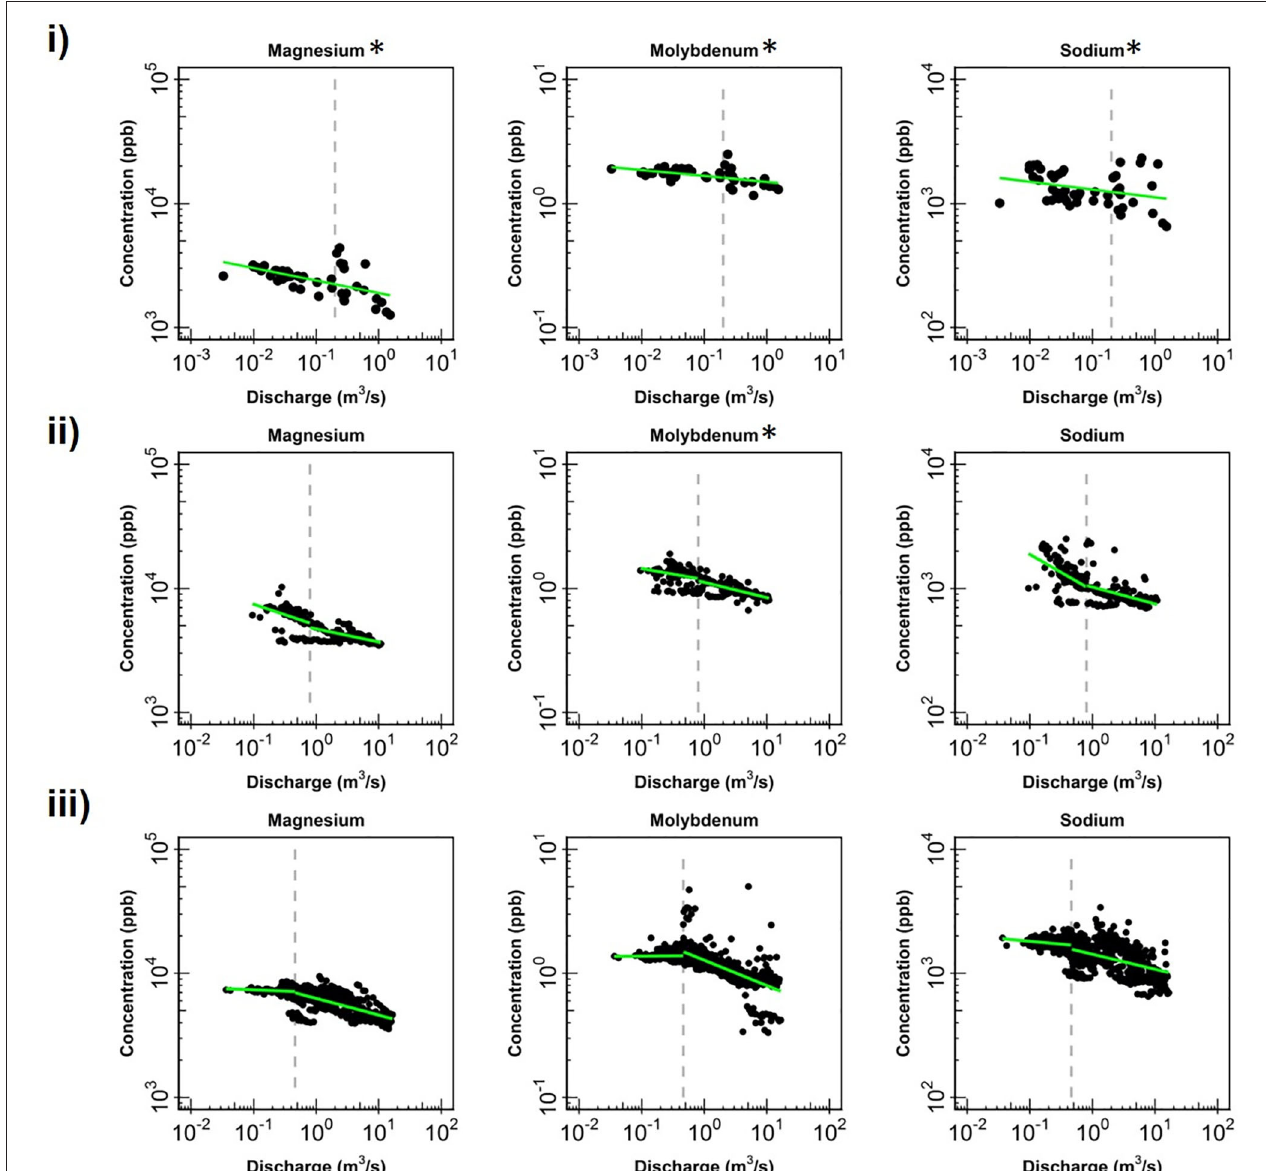
FIGURE 4 | Change in log-log relationships for Mg, Mo and Na at (i) EAQ, (ii) EBC, and (iii) PH when segmenting the hydrograph at the median discharge (dashed gray line). Low flows indicate values below the median discharge and high flows indicate values above the median discharge. Green lines represent segmented linear fits to the data, and * indicates if slopes at low and high flows are significantly similar to each other at 0.10 level.